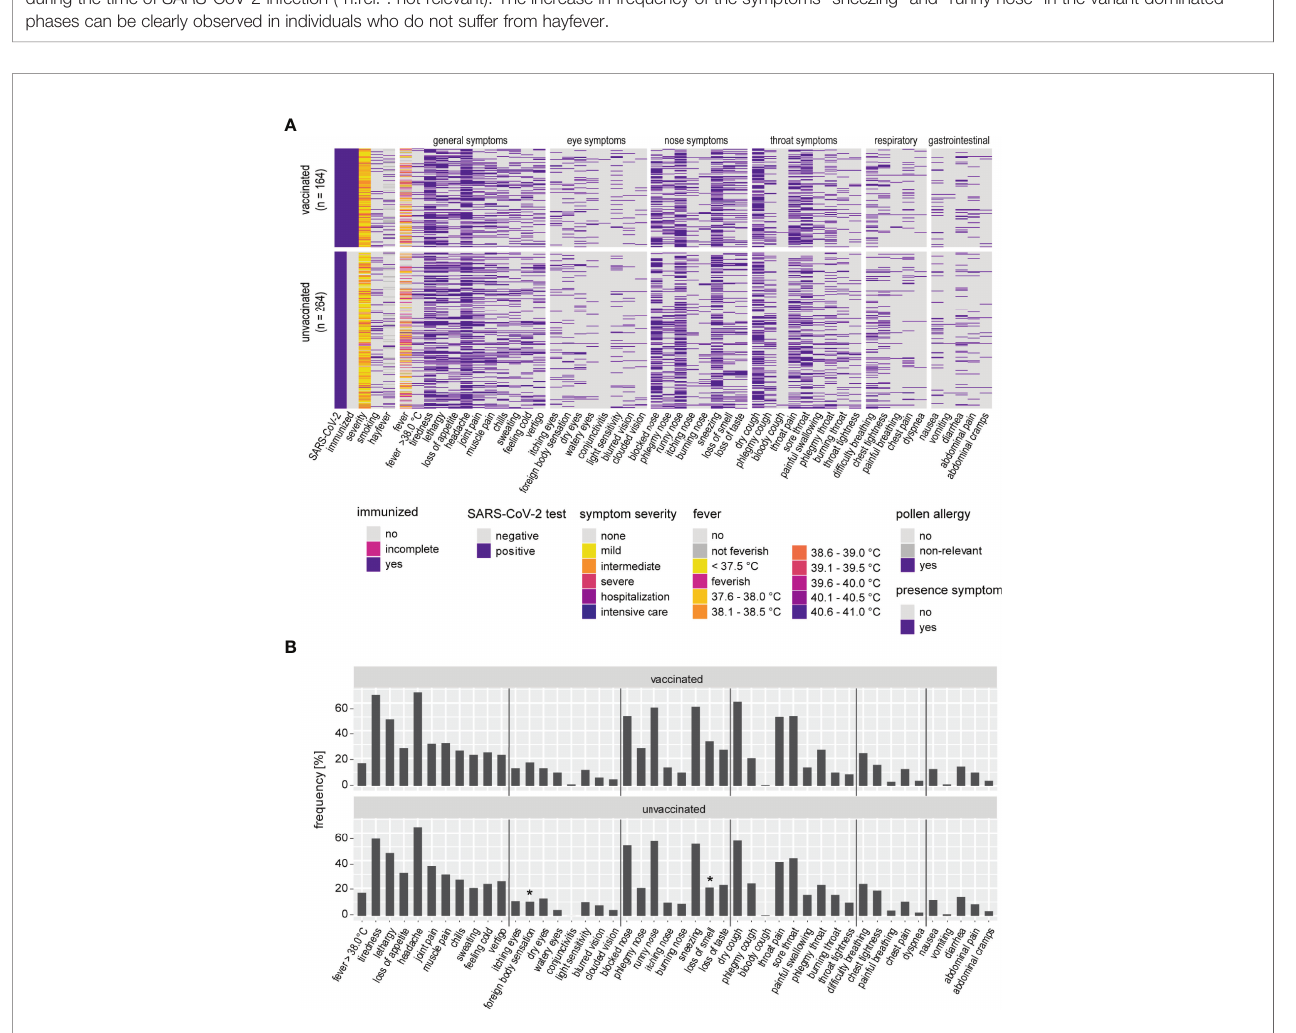
FIGURE 5 | Symptoms reported during the omicron-dominated phase strati fi ed by vaccination status. (A) Heatmap of SARS-CoV-2 infected vaccinated (upper section) and unvaccinated (lower section) individuals from the omicron-dominated phase. (B) Frequencies for each symptom were calculated for vaccinated and unvaccinated SARS-CoV-2 positive individuals. Statistically signi fi cant differences are indicated by * ( p < 0.05, Fisher ’ s exact test).